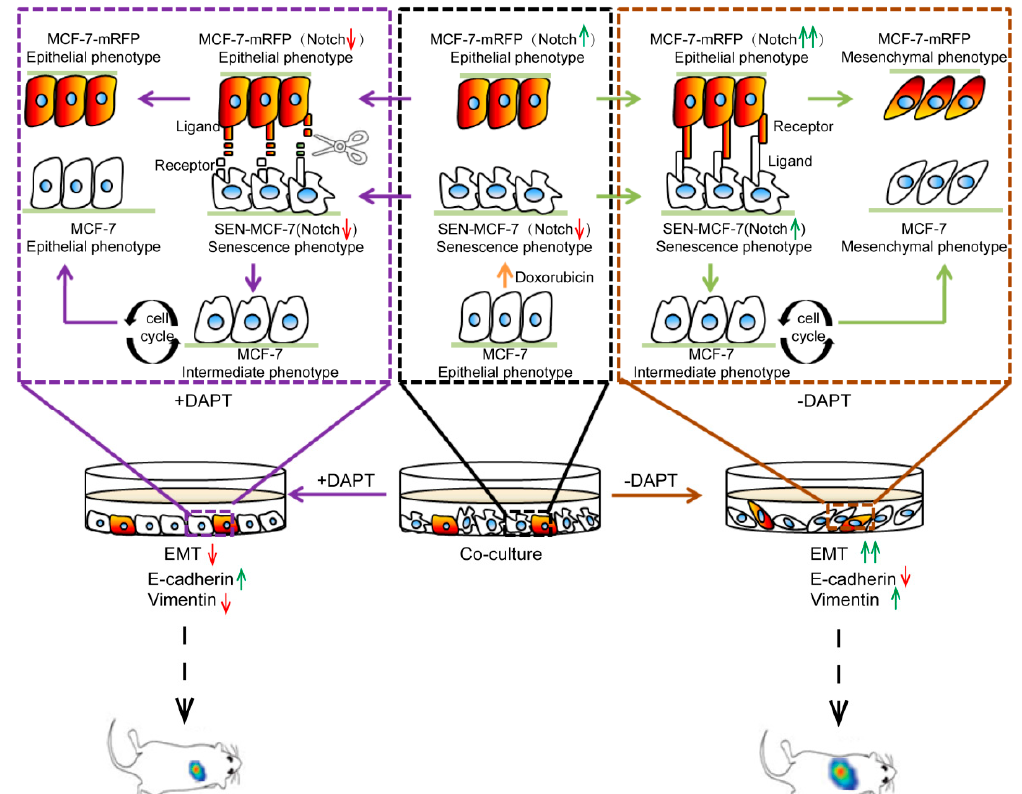
Figure 5. Role of Notch signaling in EMT caused by doxorubicin-induced tumor cells senescence. A proposed working model of Notch signals involved in breast cancer EMT in the co-cultivation system of senescent breast cancer cells induced by doxorubicin co-cultured with adjacent non-senescent breast cancer cells. Interactions between senescent (SEN-MCF-7) and adjacent non-senescent breast cancer cells (MCF-7-mRFP) through activating the Notch signal promote EMT of adjacent non-senescent breast cancer cells (MCF-7-mRFP) through Notch signaling, accompanied by the downregulation of E-cadherin and upregulation of Vimentin. Meanwhile, senescent breast cancer cells (SEN-MCF-7) return to the cell cycle and acquire migration and invasion ability and EMT properties, which is accompanied by the downregulation of E-cadherin and upregulation of Vimentin. Notch signaling in senescent (SEN-MCF-7) and adjacent non-senescent breast cancer cells (MCF-7-mRFP) is inhibited by treatment with DAPT in the co-cultivation system, which is accompanied by the downregulation of E-cadherin and upregulation of Vimentin in breast cancer cells. Red arrows: inhibition of signaling or downregulation of protein expression. Green arrows: activation of signaling or upregulation of protein expression.